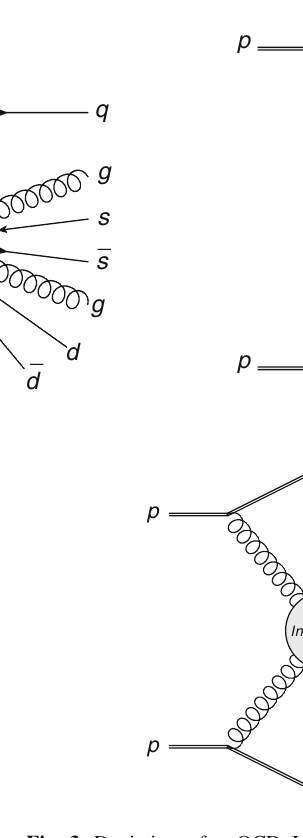
Fig. 3 Depiction of a QCD Instanton processes in proton–proton (right) collisions without the requirement of an external scale parameter Q